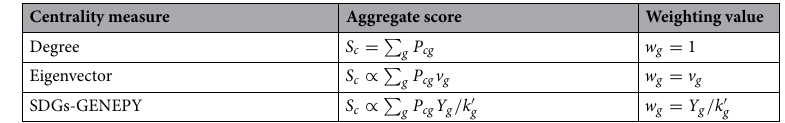
Table 1. Weighting approaches through different centrality metrics. In the formulas: S c is the aggregate score for country c , generally defined according to Eq. (2); P cg is the value of countries’ performances in Goal g ; w g is the weighting value defined in Eq. (2); v g is the centrality score for SDGs according to the eigenvector centrality, Eq. (3); Y g is the centrality score for SDGs according to the SDGs-GENEPY framework, Eq. (4), and = P cg / k c is the adjusted Goals’ degree (see “Materials and methods” k ′ g c (cid:31)